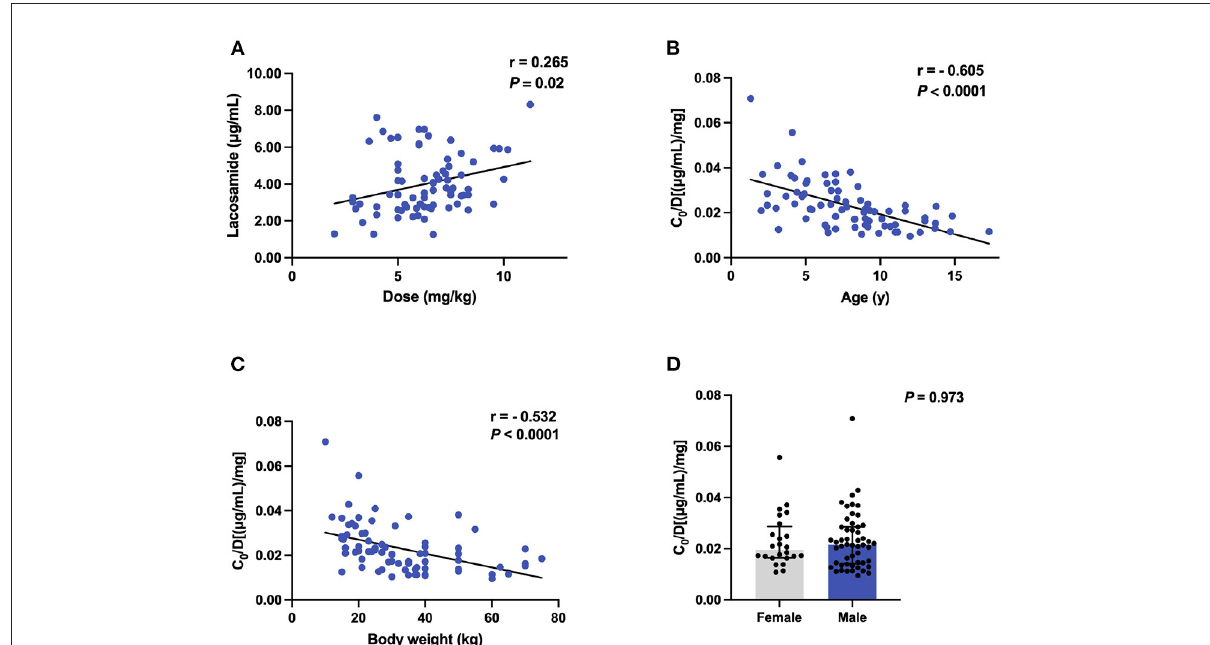
FIGURE3 The C 0 and C 0 /Dose ratio [( µ g/mL)/mg] of LCM in polytherapy ( n = 76). (A) Correlation between C 0 and dose (mg/kg); (B) Correlation between C 0 /Dose ratio and ages; (C) Correlation between C 0 /Dose ratio and BW; (D) A comparison of C 0 /Dose ratio in both sexes.